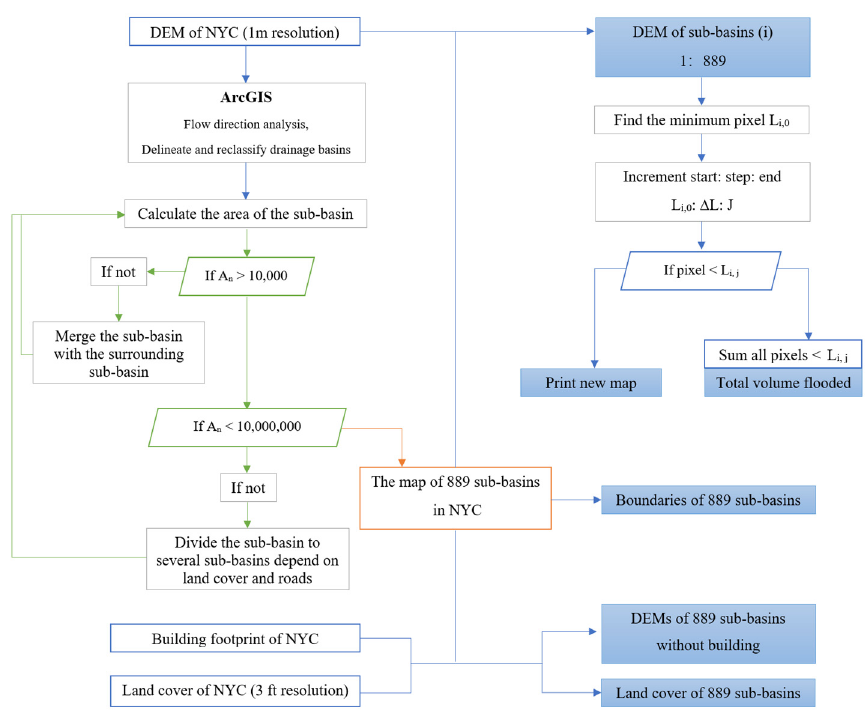
Figure 1. The process of dividing NYC into 889 sub-basins and database processing. Additionally, the 3 ft (0.91 m) resolution raster image of NYC and the shapefile of footprint outlines of buildings in NYC are also parts of the database preparation. From these two files, digital elevation (DEM) files of sub-basins without buildings can be